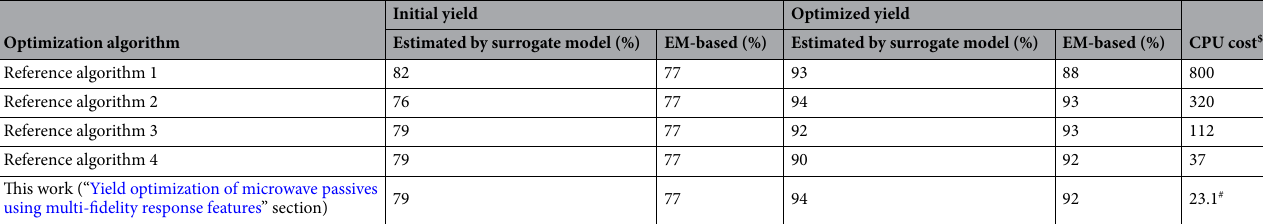
Table 5. Design centering results for Circuit II (Fig. 5(b)). $ Optimization cost in number of EM simulations of the considered circuit. # Equivalent number of high-fidelity EM simulations (actual number of analyzes was 7 high-fidelity and 44 low-fidelity).